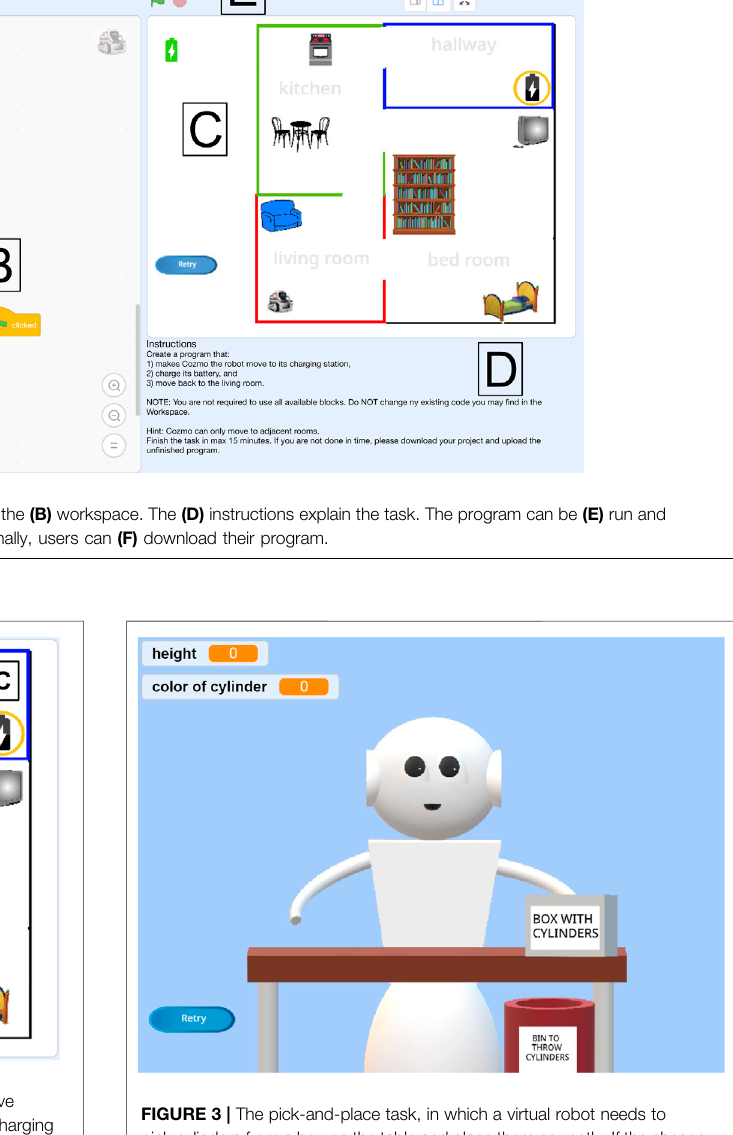
FIGURE 3 | The pick-and-place task, in which a virtual robot needs to pick cylinders from a box on the table and place them correctly. If the chosen cylinder ’ s color is pink, the robot must place it on the table; otherwise it must beputinthebinbelowthetable.Itshouldstackcylindersuntilthestack ’ s height is